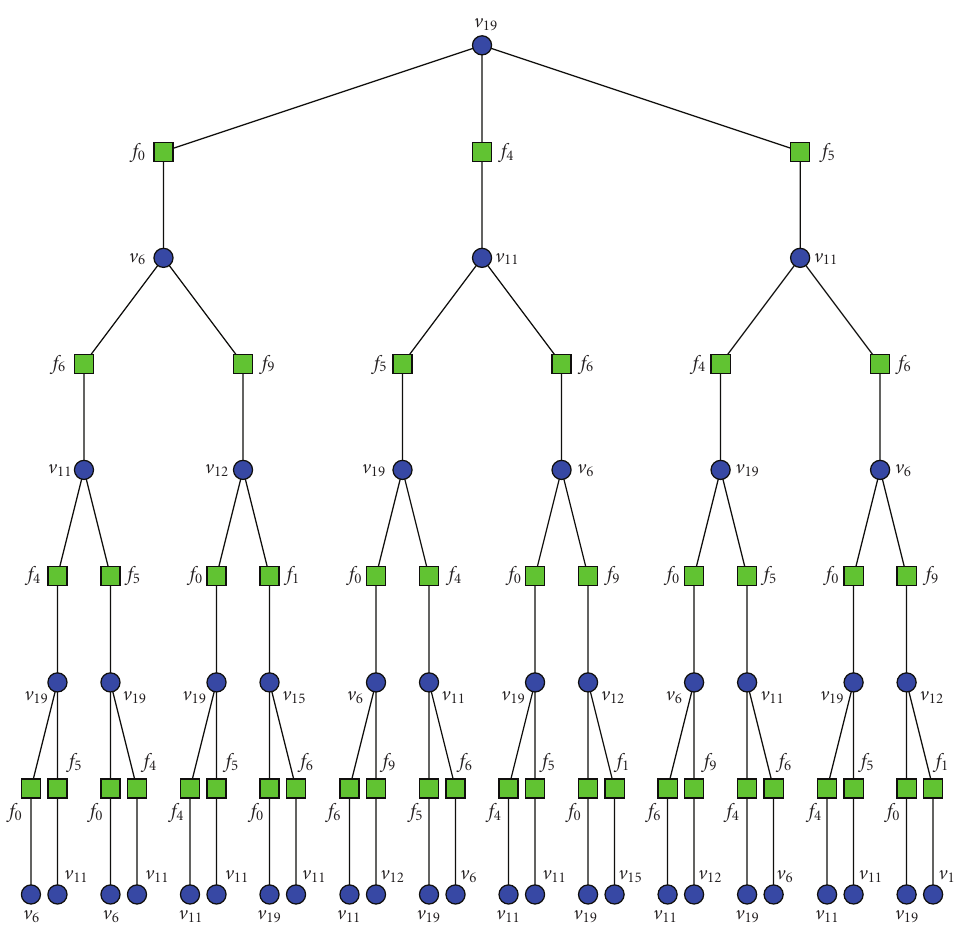
Figure 8: Deviation designed to maximize the number of copies of v 11 and v 19 .